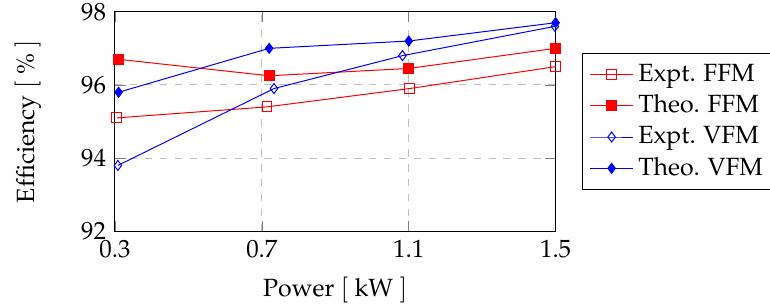
Figure 15. Prototype Power Efficiency. ( U 1 = 80V, U 2 =